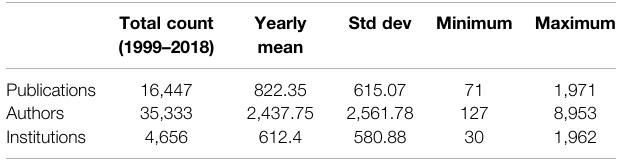
TABLE 2 | Summary statistics by